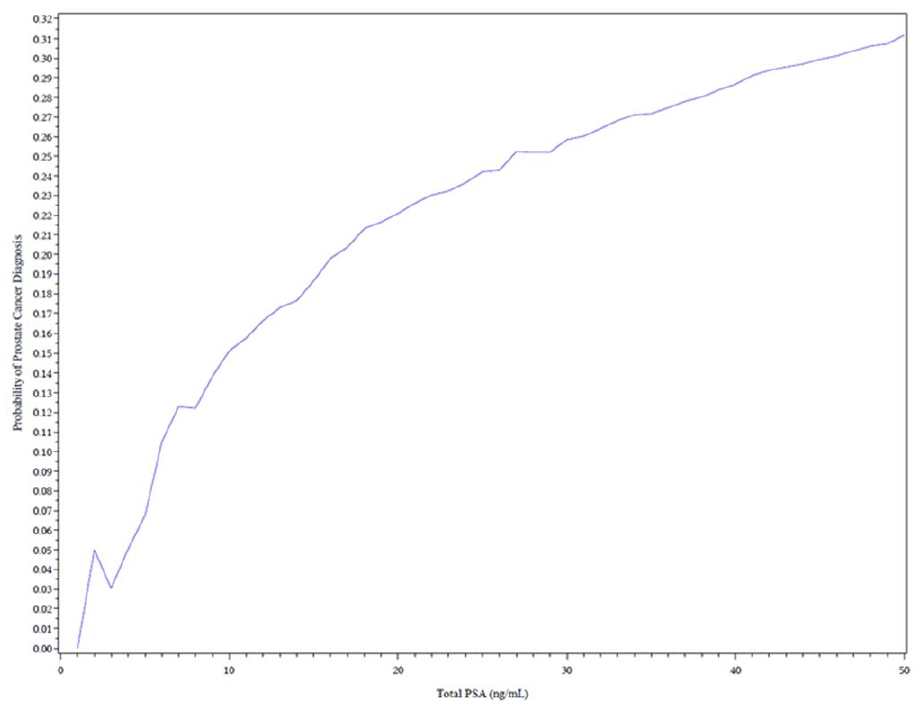
Figure 3. Probability of having prostate cancer with increasing PSA in biopsy population. The probability of having prostate cancer when undertaking prostate biopsy is raised from nearly 0% with tPSA , 1.0 ng/mL to nearly 31% with tPSA=50 ng/mL according to our study population. This figure can be use to predict the probability with tPSA level in the future.